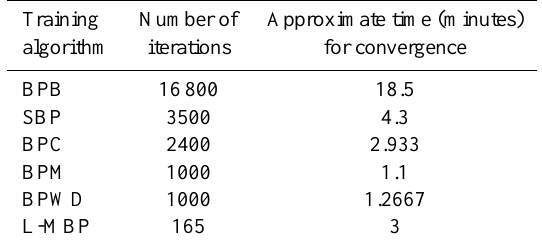
Table 1. Approximate number of iterations and time taken (in min- utes) for generalisation to be achieved for different training algo-